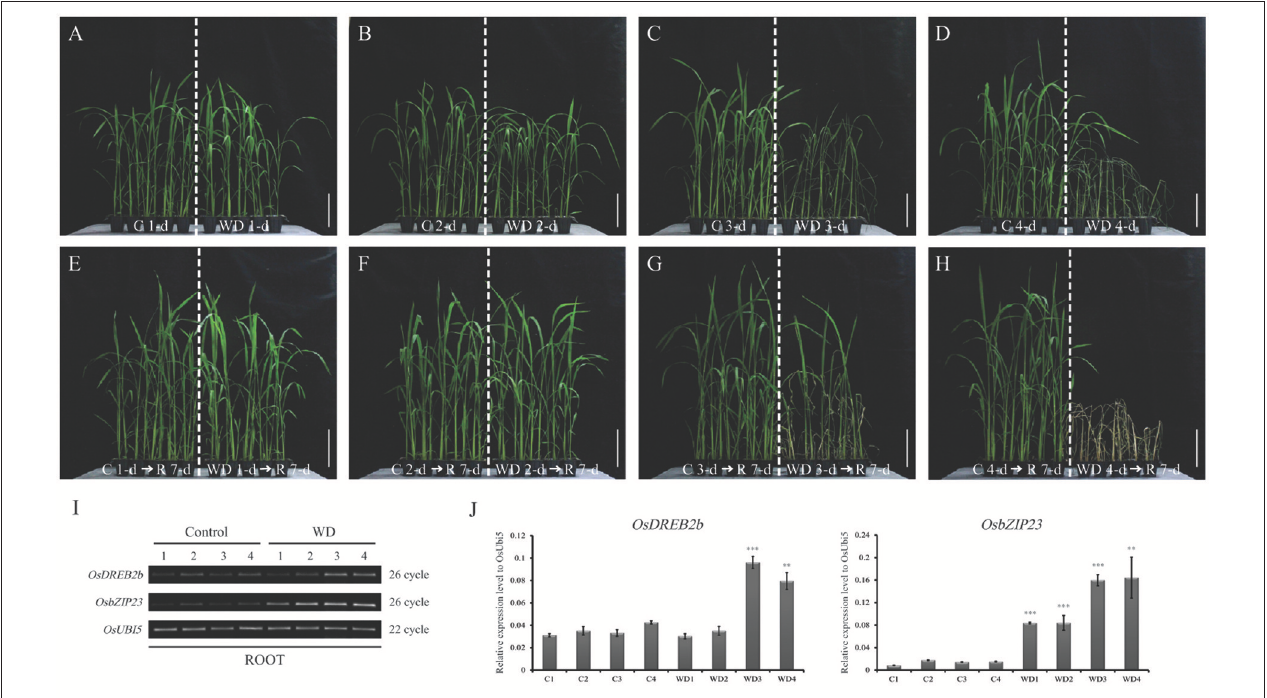
FIGURE 1 | Physiological responses under drought stress of rice seedlings grown in soil. Rice cultivar Chilbo grown in plastic pots for 4 weeks was exposed to water deficiency (WD) for 1 (A) , 2 (B) , 3 (C) , or 4 (D) d and then recovered for 7-d (E–H) . Effects of WD were checked by monitoring expression patterns of drought-stress marker genes (I,J) . Y-axis indicates expression level relative to OsUBI5/Os01g22490 (internal control); x-axis, samples used for qRT-PCR (J) . C1, C2, C3, and C4, untreated control (roots from well-watered pots) corresponding to plants under 1d of water deficiency (WD1d), 2d (WD2d), 3d (WD3d), and 4d (WD4d). ** P < 0.01; *** P < 0.001. Scale bar = 10 cm. N =